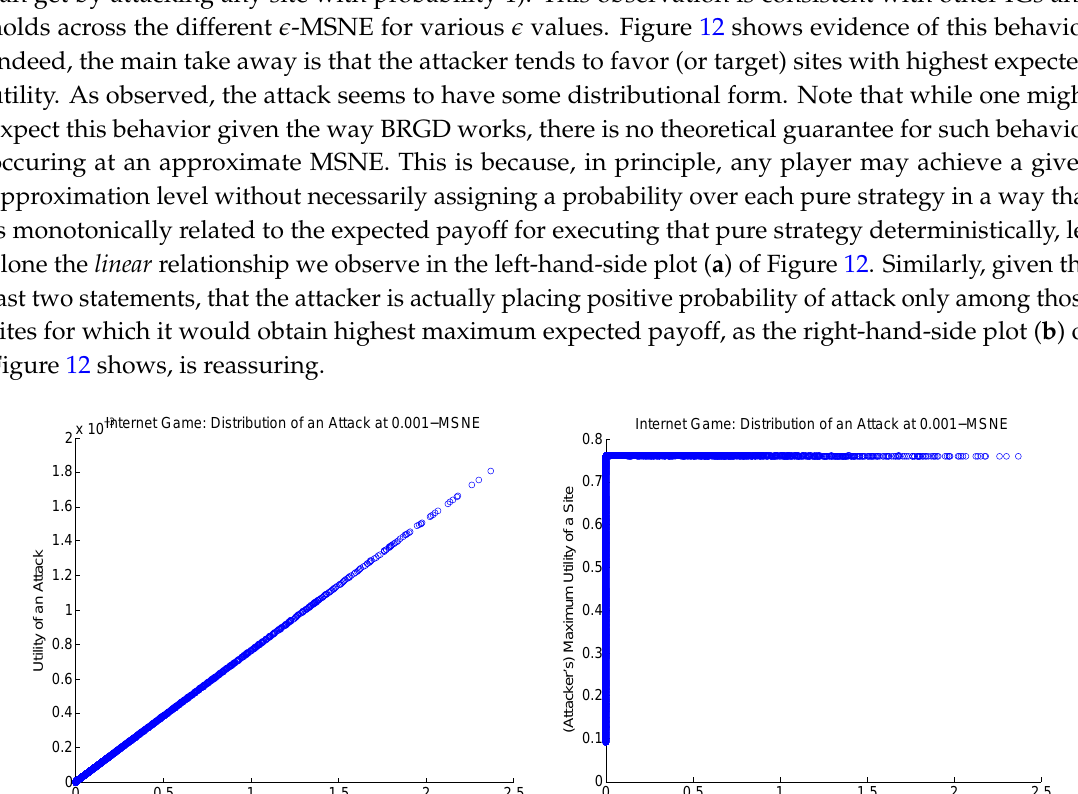
of attacking the i